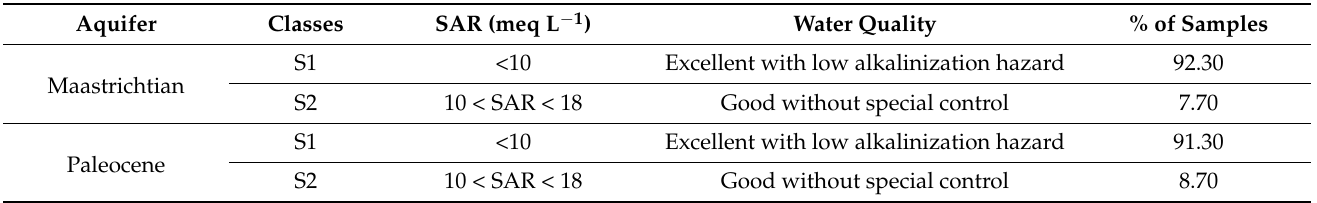
Table 4. Classification of the groundwater quality according to the sodium adsorption ratio